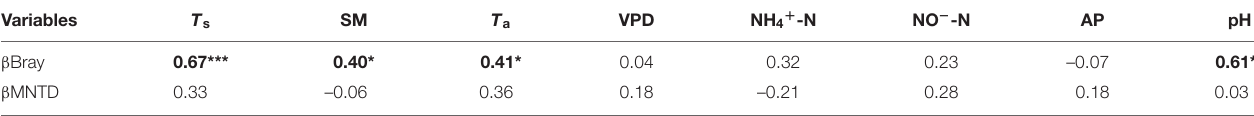
TABLE 3 | Correlation analyses of species and phylogenetic β -diversity with the Bray-Curtis dissimilarity index of environmental variables, between the control treatment at site A (C4300) and the warming treatment at site B (W4500), between the C4300 treatment and the warming treatment at site C (W4700), and between the control treatment at site B (C4500) and the W4700